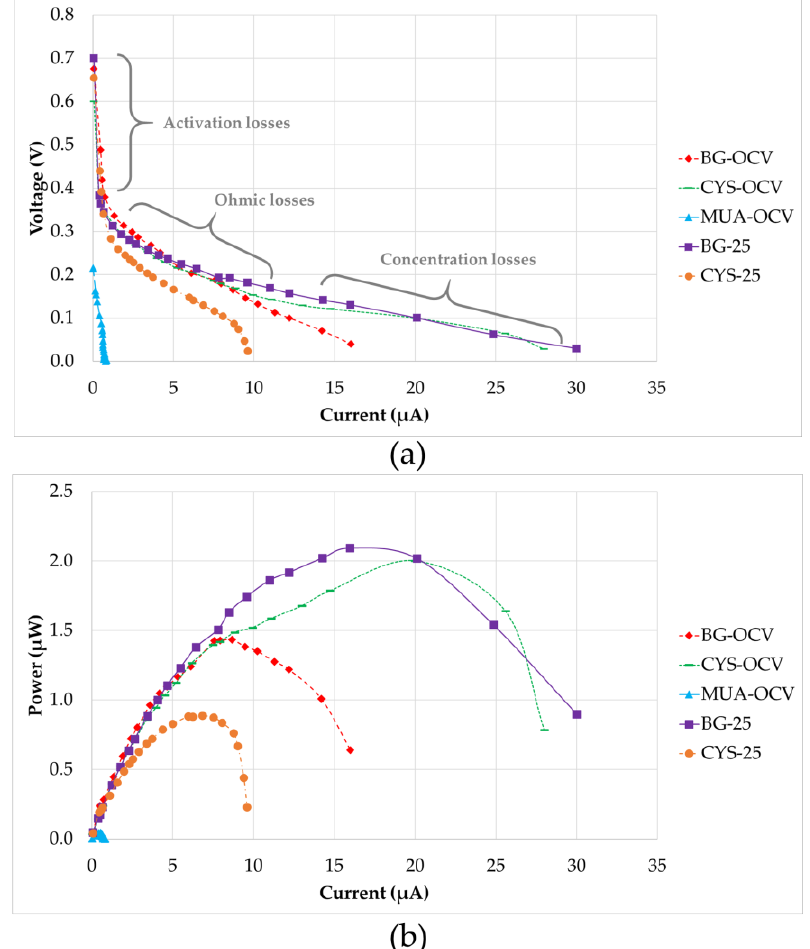
Figure 7. ( a ) Polarization curves (the regions are shown approximately) and ( b ) power output